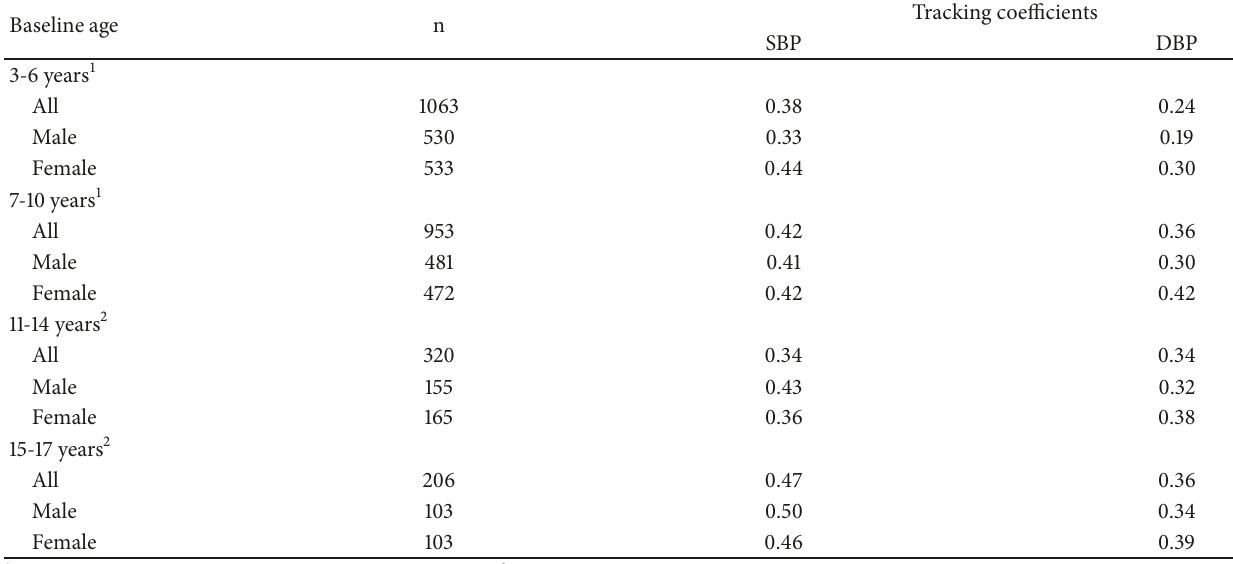
Table 2: Spearman rank-order correlation coefficients for six year-tracking of BP in children and adolescents in Germany. Baseline age